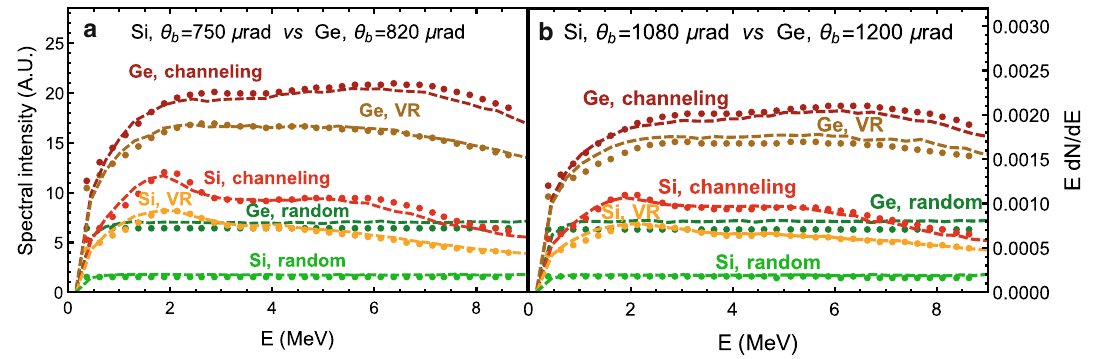
Fig. 2 Experimental (lines) and simulated (points) radiation spectral intensities for channeling (θ x ∼ 0 µ rad), volume reflection (θ x ≈ − θ / 2 ) and random orientation ( θ > 9 mrad) for both Si and Ge b x